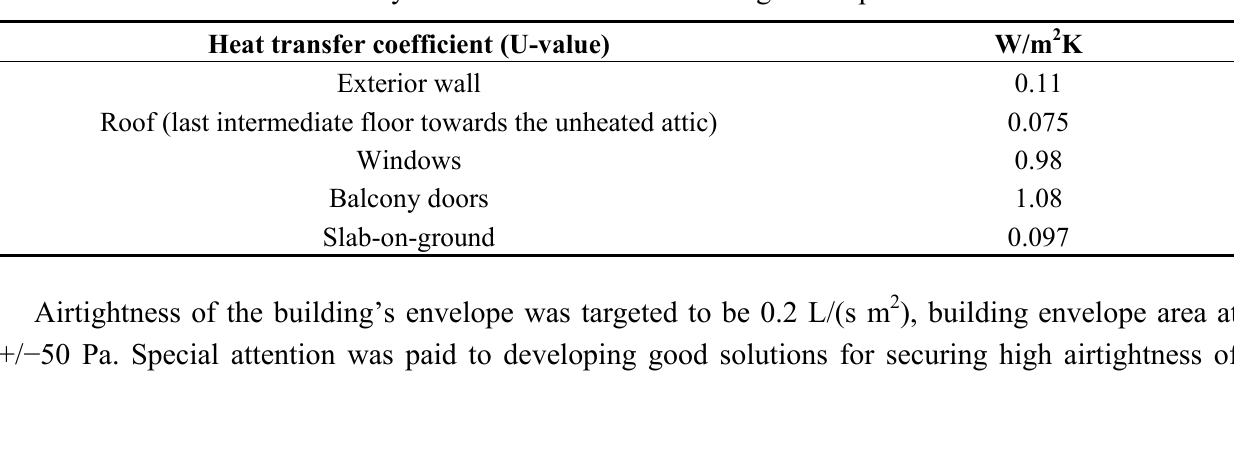
Table 2. Summary of the U-value of the building envelope and